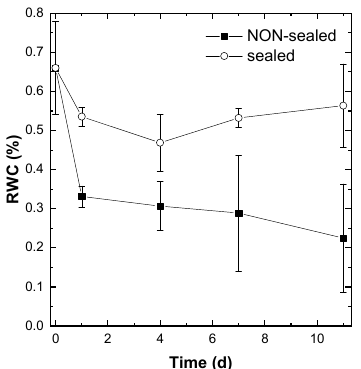
Figure 3. Changes in the relative water content during storage of the non-sealed (closed symbols) and sealed (open symbols) fresh-cut lettuce leaves. Average ± SE values are presented ( n = 9).